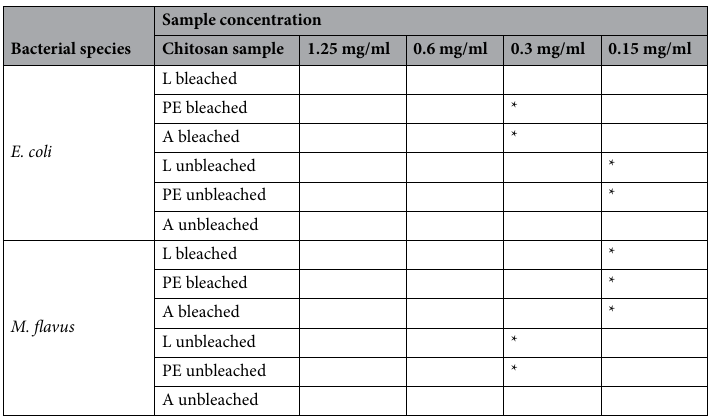
Table 2. MIC values of bleached and unbleached chitosan samples produced from H. illucens larvae (L), pupal exuviae (PE) and dead adults (A).